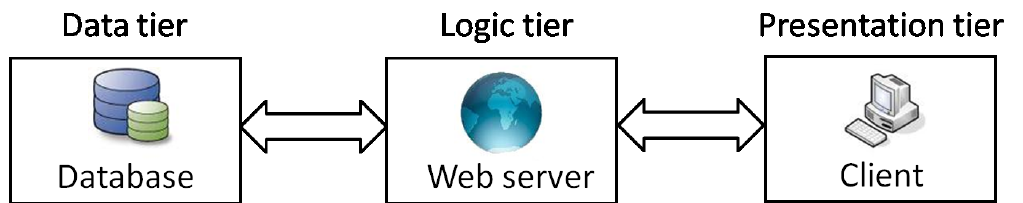
Figure 1: The three-tier architecture is being instanciated by the DBE2 information system. The presentation tier (the DBE2 client ) calls the logic tier to download, upload, and edit biological data. The logic tier (the DBE2 servlet ) employs the data tier (the DBE2 database and a file storage system) for the storage of experiment data and binary files. This happens using an underlying user management to manipulate or transfer data by defined